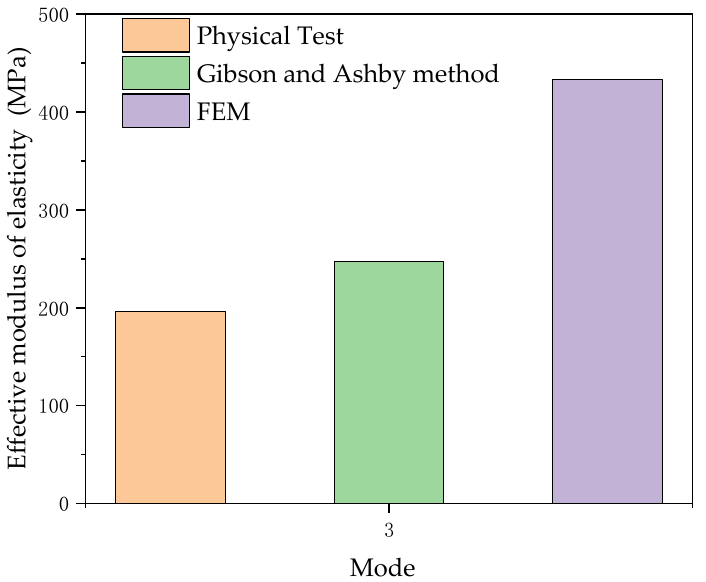
Figure 12. Comparison of equivalent elastic moduli of the three methods in model 3.